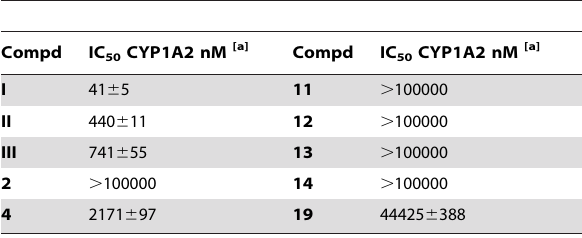
Table 2. Inhibition of human hepatic enzyme CYP1A2 by selected